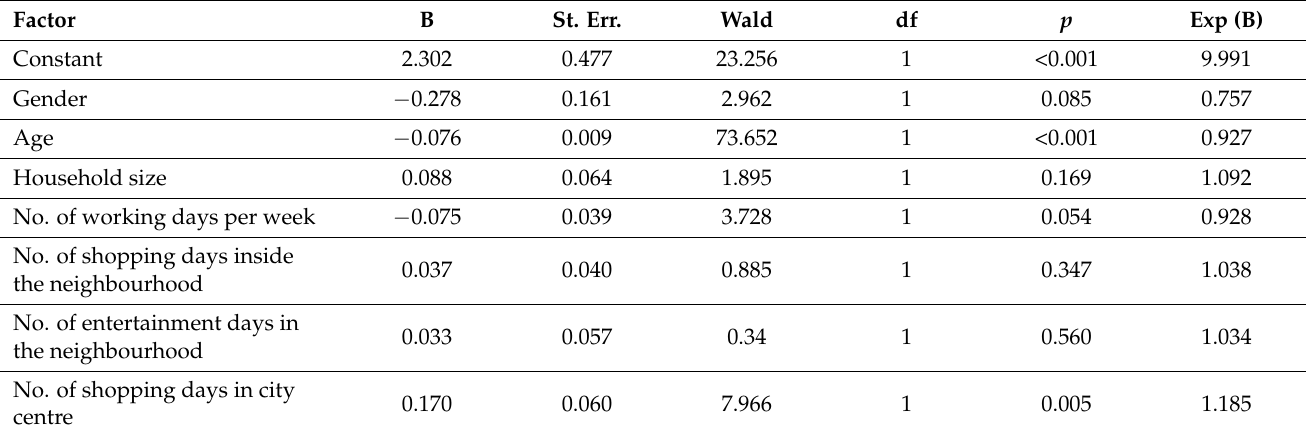
Figure 1. Visualization of the descriptive relationship between the number days of traveling for different purposes and household car ownership for male and female respondents. Table 5. Binomial logistic regression model of public transportation ridership in Kerman (N =